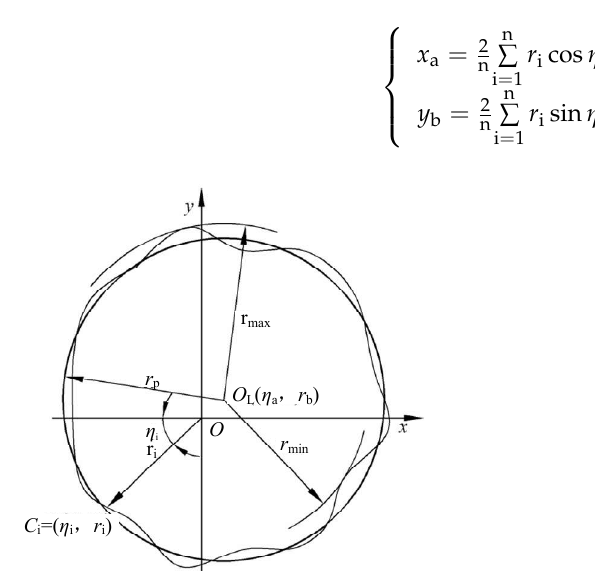
Figure 6. Diagram of least squares circle.